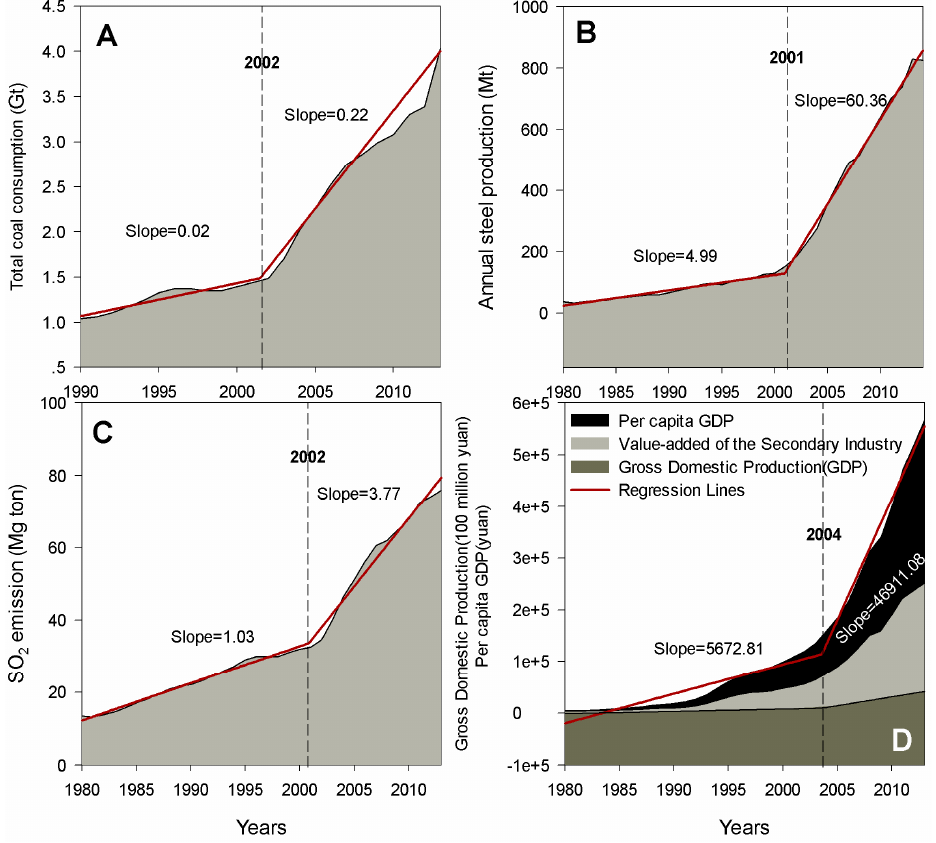
Figure 1. Annual coal consumption (1990–2014 ( A )); the demand for steel (1980–2014 ( B )); the total